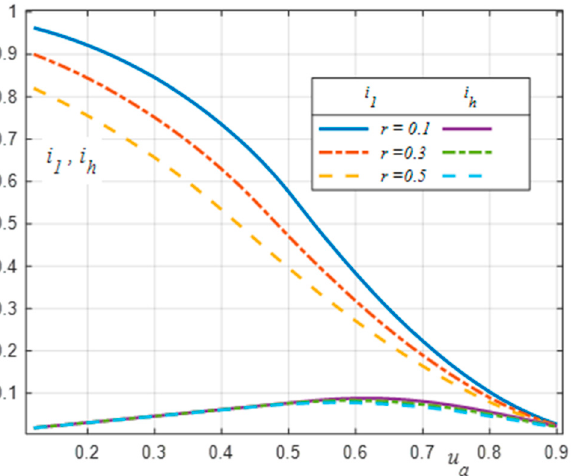
Figure 5. Amplitudes of the first harmonic and higher harmonics of the circuit current as a function of the load voltage amplitude and resistance. of the load voltage amplitude and resistance.